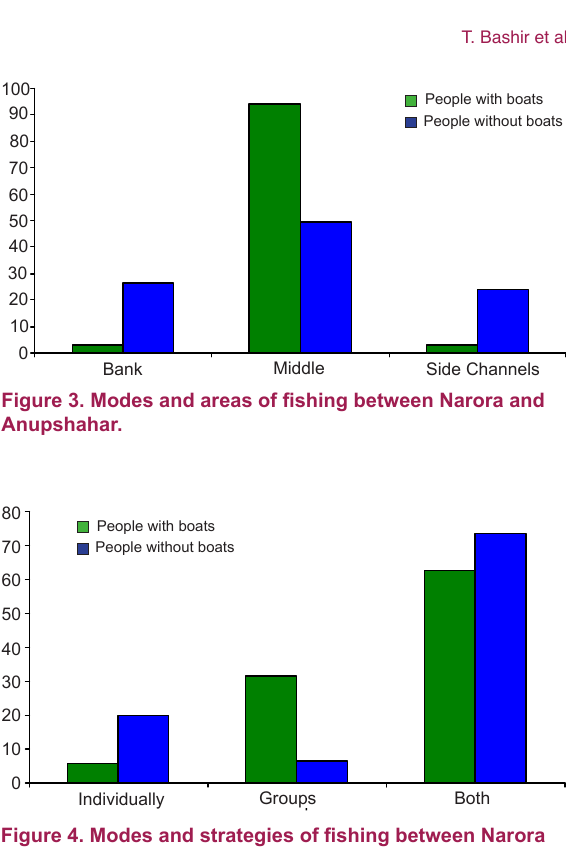
Figure 4. Modes and strategies of fishing between Narora and Anupshahar.